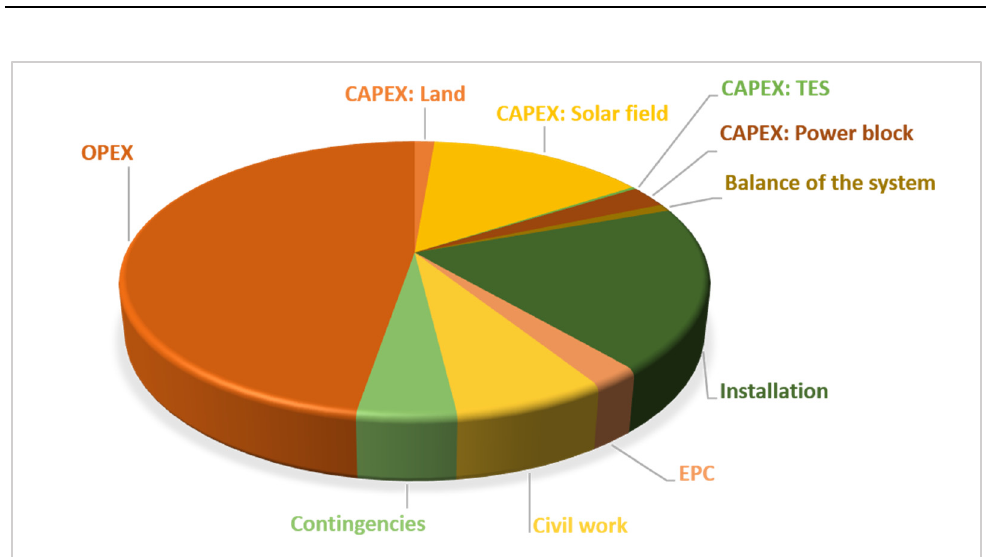
Figure 6. Share of expenses for base case solar power tower plant over 25 years.